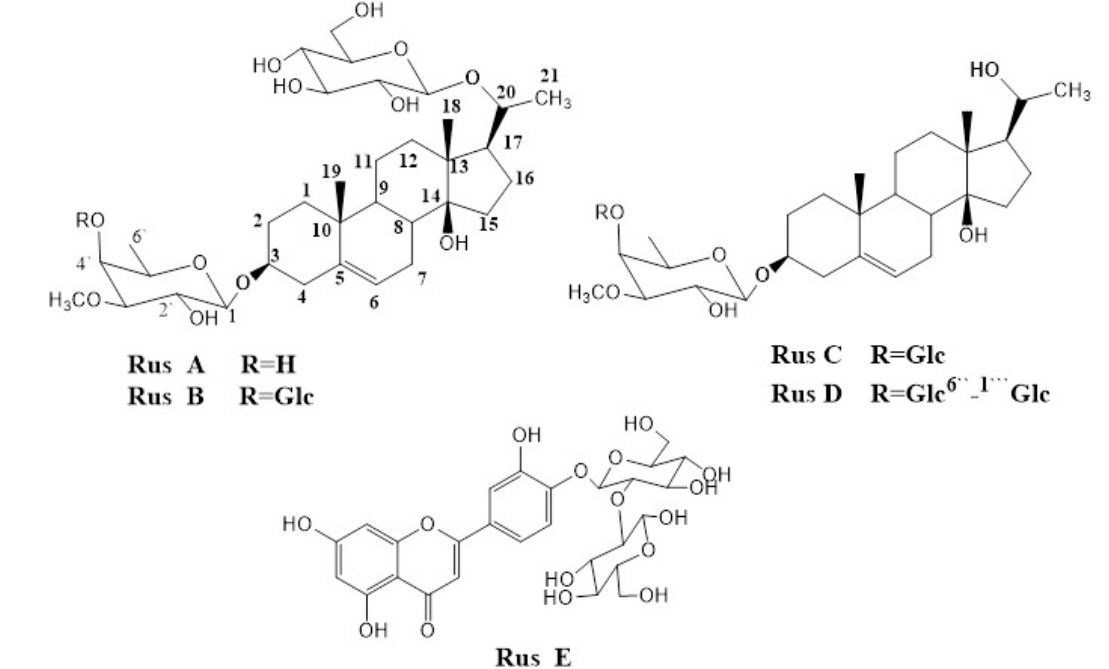
Figure 4. Chemical structures of russeliosides A – E .